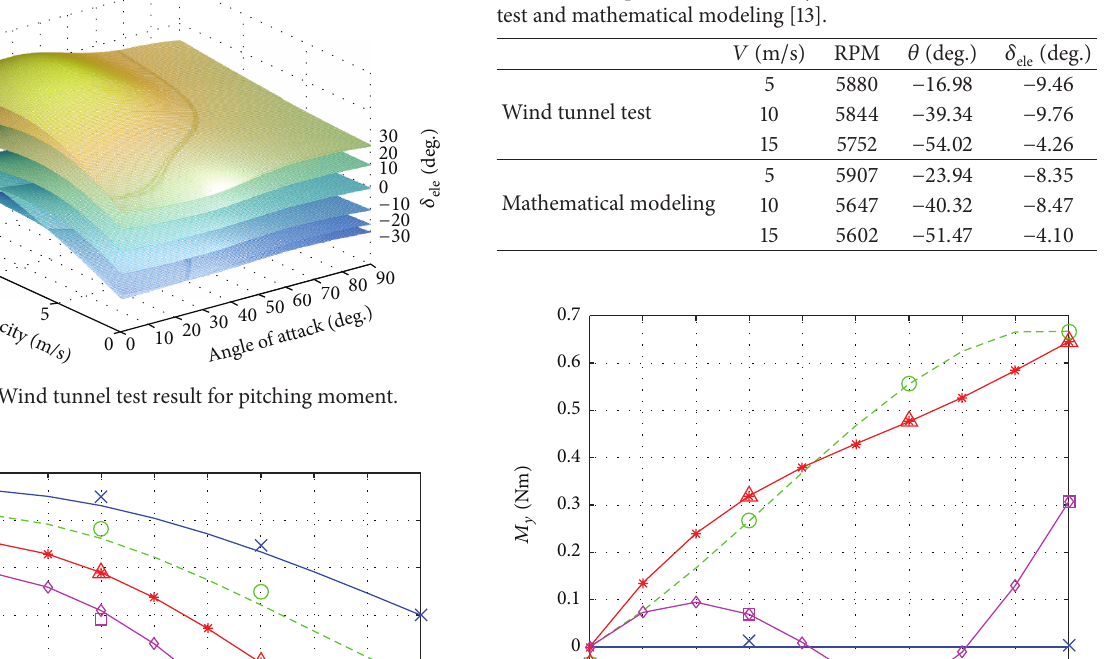
Table 2: Comparison of trim analysis results between wind tunnel